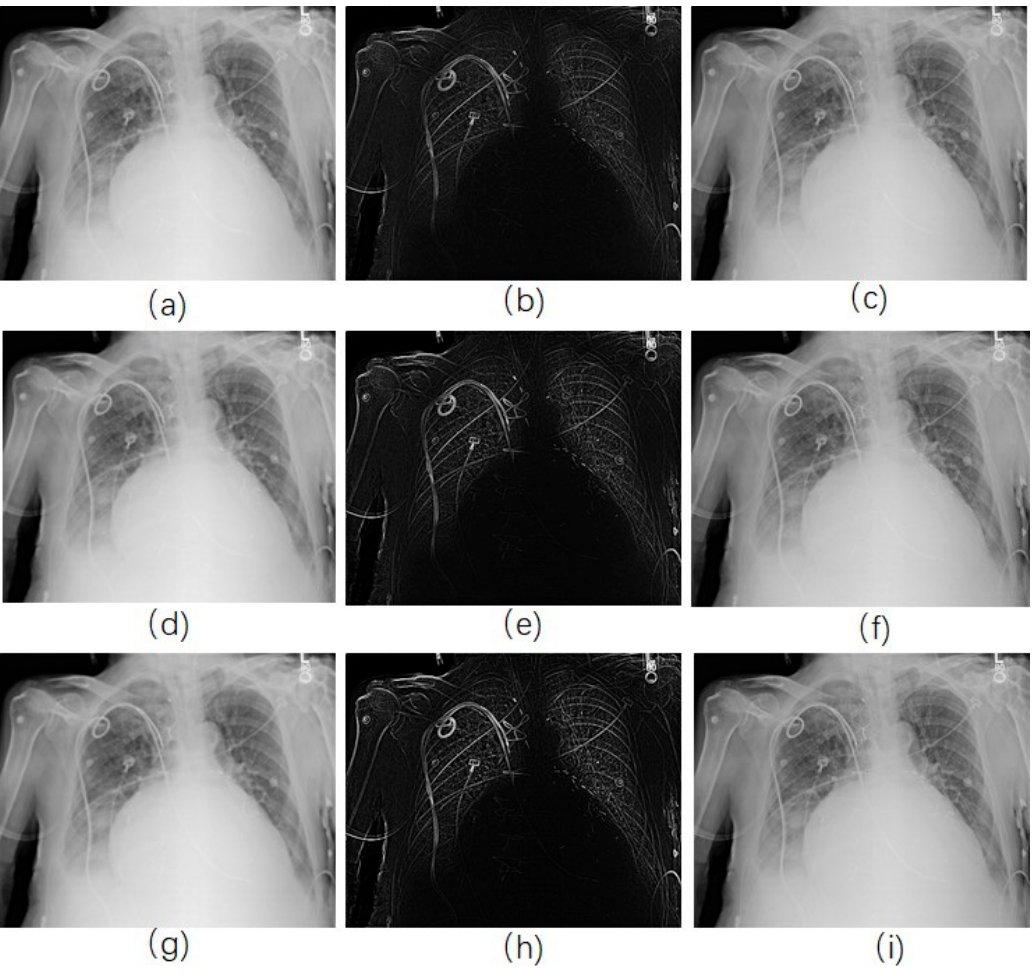
Figure 4. CXR enhancement by use of traditional USM model. ( a , d , g ) were the smoothed images by use of 15 × 15, 19 × 19, 23 × 23 Gaussian kernel, respectively; ( b , e , h ) were the corresponding Unsharp masks to ( a , d , g ); ( c , f , i ) were the corresponding enhanced images.